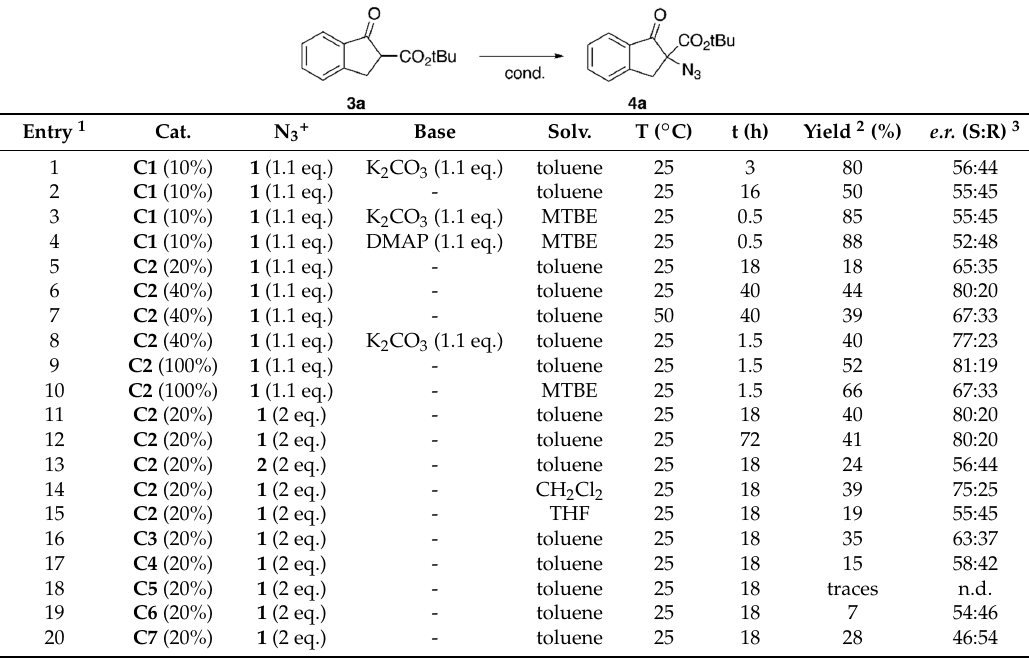
Table 1. Screening and optimization of the α -azidation of 3a with hypervalent iodine-transfer reagents.